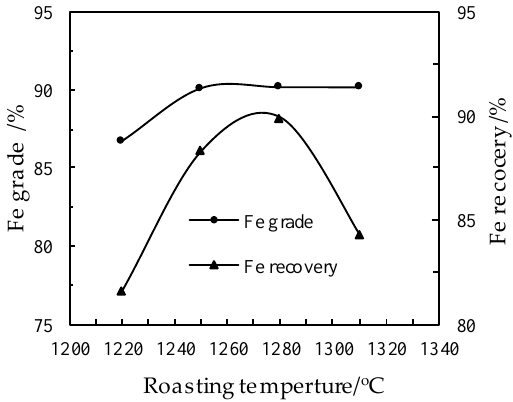
Figure 5. Effect of reduction temperature on the DR process.